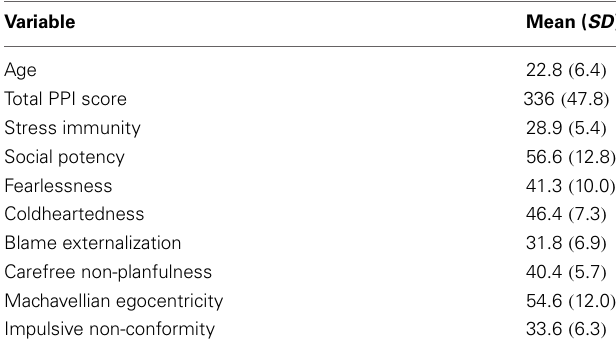
Table 1 | Mean total PPI score and subscale scores for the experimental sample ( n =